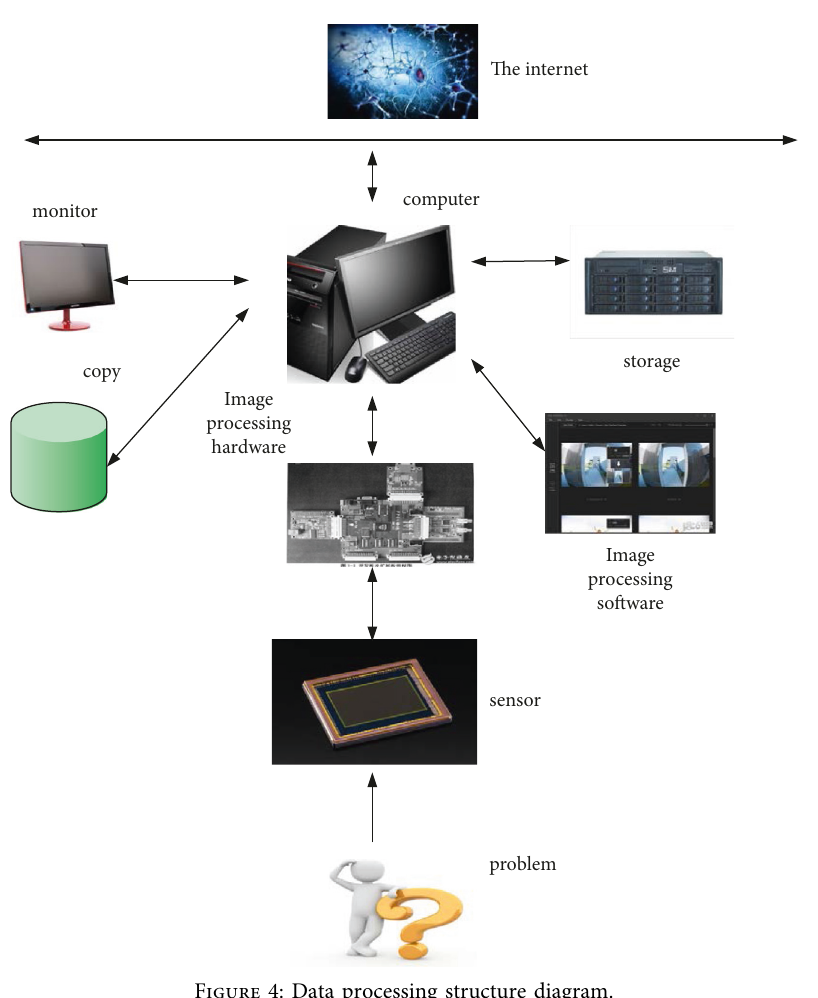
Figure 4: Data processing structure